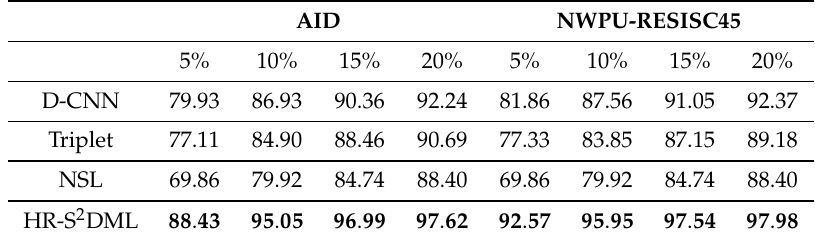
Table 4. MAP scores (%) of the image retrieval results obtained by the considered methods, when the percentages of the labeled images are 5%, 10%, 15%, and 20%, respectively, using R = 20. AID